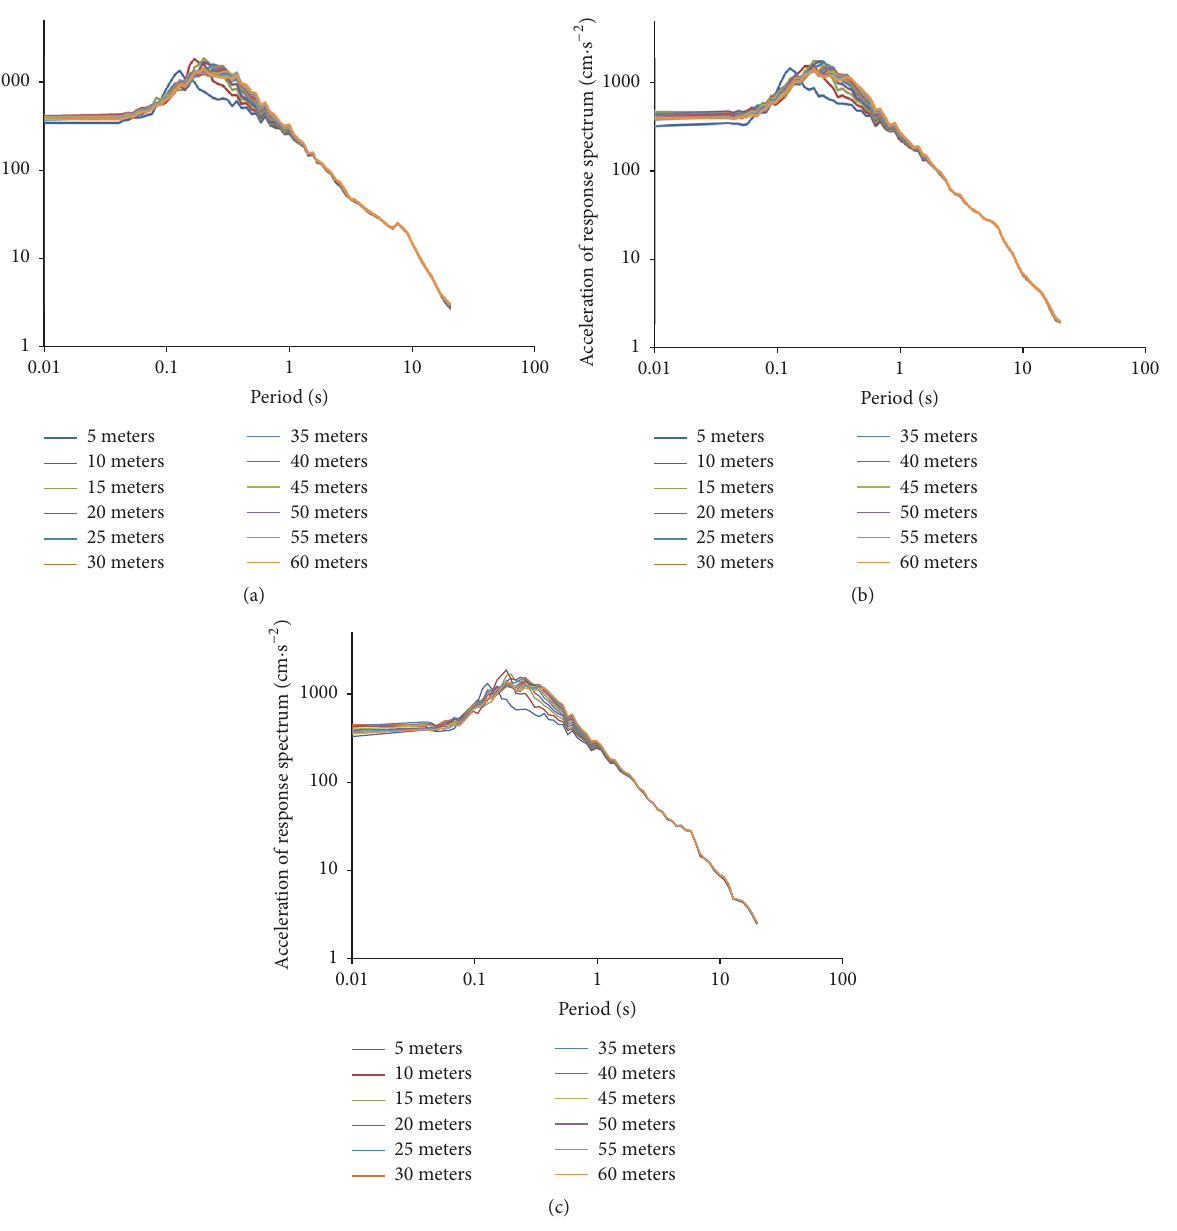
Figure 3: Acceleration spectra under seismic ground motion with exceedance probabilities of 10% in 50 years: (a) schedule 1 of the seismic waves; (b) schedule 2 of the seismic waves; (c) schedule 3 of the seismic waves.